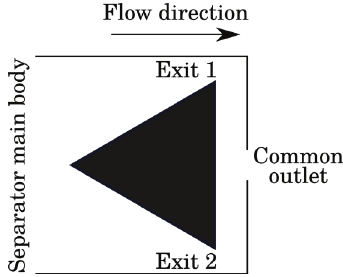
Fig. 2 – Sketch of the split outlet. The mixture flows from left to right and is forced out of both exits (1 and 2), and then flows out of the common